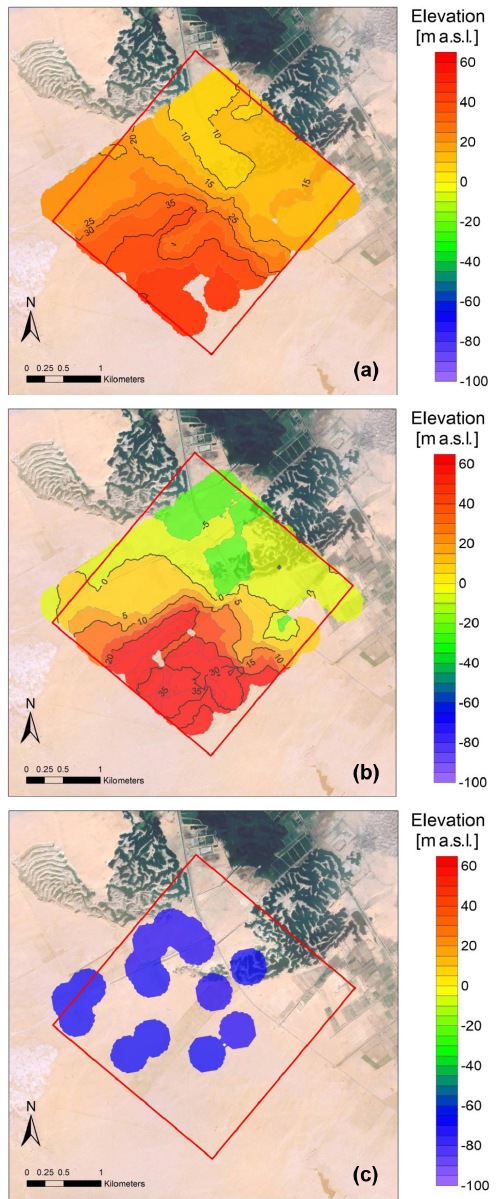
Figure 11. Elevation maps (ma.m.s.l.) of (a) the top of the clay unit, (b) the bottom of the clay unit, i.e., the top of the limestone confined aquifer, and (c) the bottom of the limestone aquifer as provided by the hydrogeophysical (deep TEM) surveys and imple- mented in the local FE model. The background is a Landsat image acquired in 2014 that is available from the US Geological